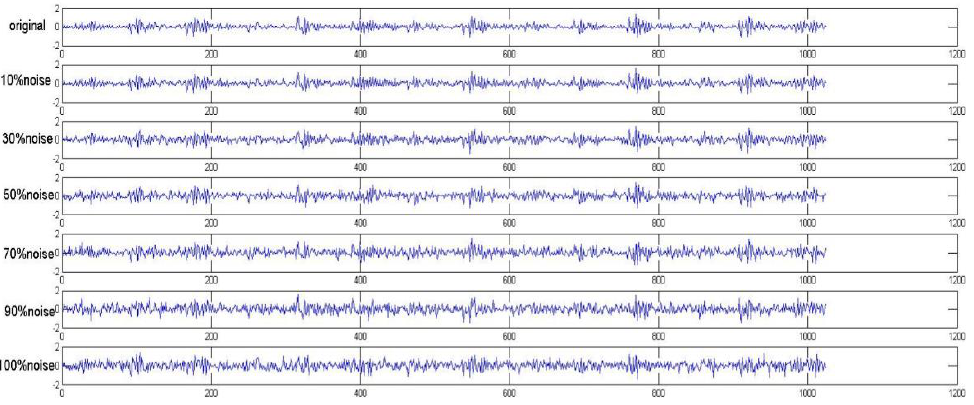
Figure 9. Original signal and signals with various percentages of added white Gaussian noise.